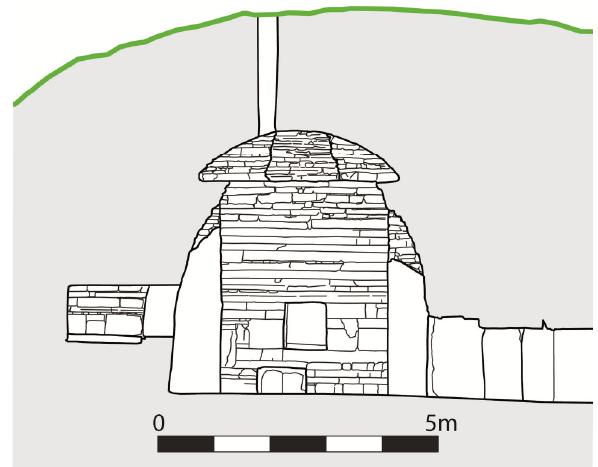
Figure 10. CAD section drawing through Maeshowe chambered tomb in a NE-SW orientation © CDDV